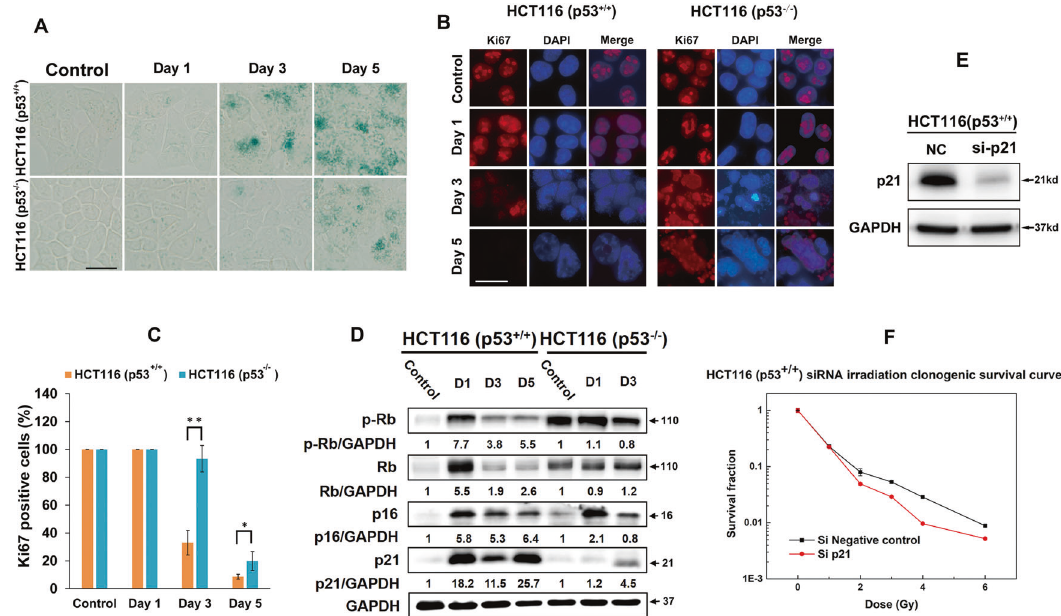
Fig. 3 CIR induces premature senescence in isogenic HCT116 colorectal cancer cells depends on p21 but not p53. A Senescent cells were determined with β -galactosidase staining at day 1, 3, and 5. Scale bar: 20 µm. B Representative images of Ki67 distribution at the indicated time points. Scale bar: 20 µm. C Quanti fi cation of the mean number of Ki67 positive cells post-irradiation. The values of all experiments represent the mean ± standard error (SE) of three independent experiments performed in triplicate. D Senescence pathway activation mediated by kinetics of p21 and p16/pRb expression was measured by western blotting. The intensities of the protein expression bands were quanti fi ed against GAPDH from the untreated control cells and are presented as fold increases below the respective lanes. D represents Day. E The ef fi ciency of p21 silencing was demonstrated by western blot analysis. NC ‚ negative control. F Clonogenic survival of p53 + / + cells transfected by siRNA p21 (Si p21) or siRNA NC. 24 h after transfection, cells were irradiated at the indicated doses. Data represent the mean of three independent experiments in triplicate, and error bars represent standard error